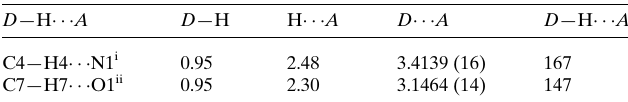
Table 1 Hydrogen-bond geometry (A˚ , (cid:3)